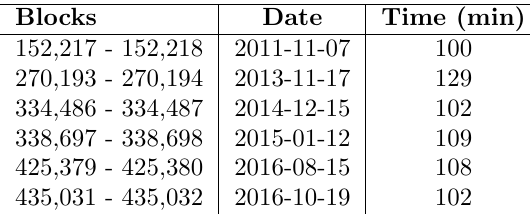
Table 1: Examples of bitcoin blocks which took 100 minutes or longer (long tail).